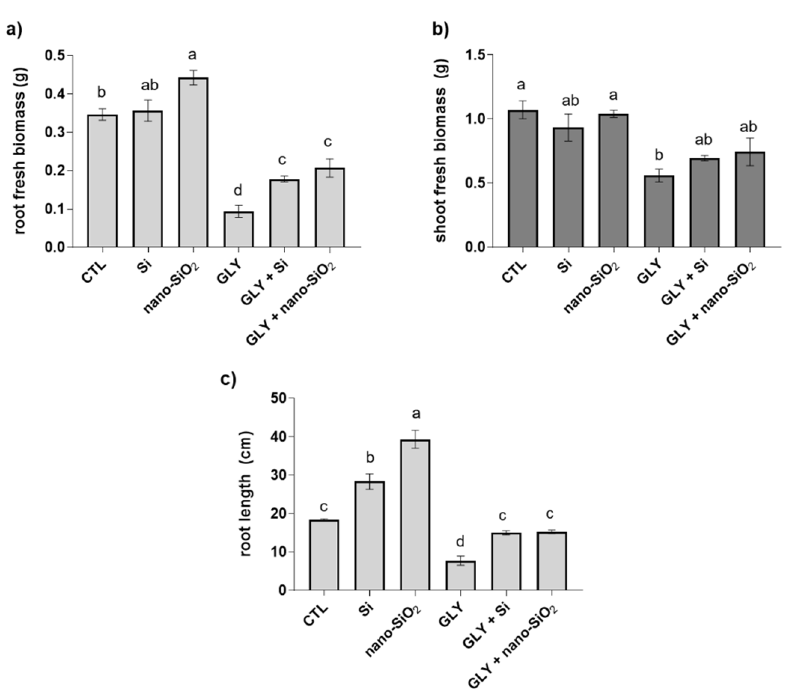
Figure 3. Biometric parameters of S. lycopersicum plants after four weeks of growth [CTL—control plants; GLY—plants exposed to GLY alone; GLY + Si—plants exposed to GLY and treated with Si and GLY + nano-SiO 2 —plants exposed to GLY and treated with nano-SiO 2 ]. ( a ) Root fresh biomass; ( b ) shoot fresh biomass and ( c ) root length. Data presented are mean ± STDEV ( n ≥ 3). Different letters (a–d) above bars indicate significant statistical differences between treatments (Tukey: p ≤ 0.05).